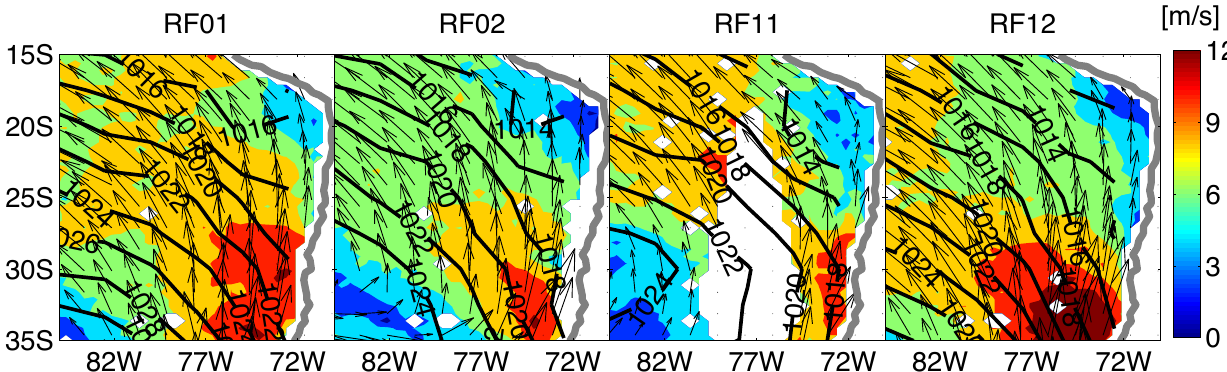
Fig. 2. Daily mean wind direction (arrows) and magnitude (colors) from NASA’s Quick Scatterometer (QuikScat). The black contours are Figure 2: Daily mean wind direction (arrows) and magnitude (colors) from NASA's 882 the reanalyzed daily sea level pressure from the NCEP/NCAR. Quick Scatterometer (QuikScat). The black contours are the reanalyzed daily sea level 883 double sideband channels at ± 1 ± 3 ± 7 and ± 14 GHz from the 183.31 GHz line (Pazmany et al., 2007). The wing-line ± 14 GHz band is best suited for retrieving liquid water be- cause of its higher sensitivity to liquid water. The